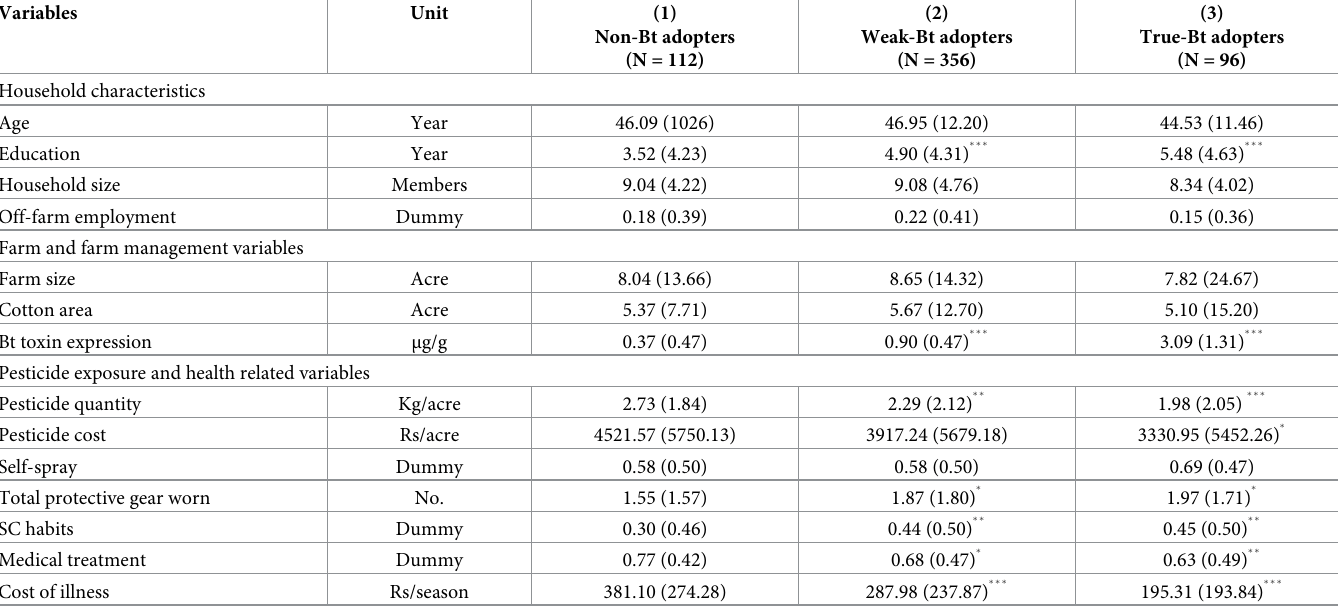
Table 3. Descriptive statistics by laboratory-based definition of Bt adoption.